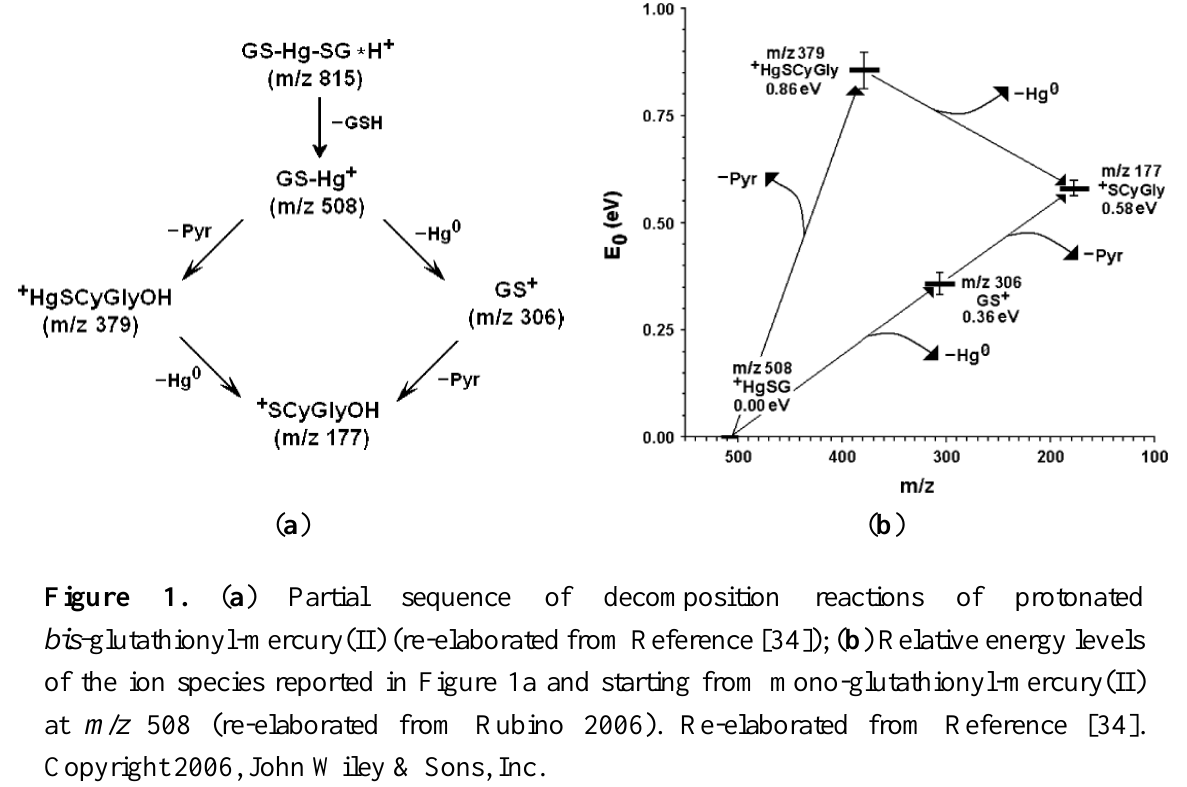
( a ) ( b ) Figure 1. ( a ) Partial sequence of decomposition reactions of protonated bis- glutathionyl-mercury(II) (re-elaborated from Reference [34]); ( b ) Relative energy levels of the ion species reported in Figure 1a and starting from mono-glutathionyl-mercury(II) at m / z 508 (re-elaborated from Rubino 2006). Re-elaborated from Reference [34]. Copyright 2006, John Wiley & Sons,